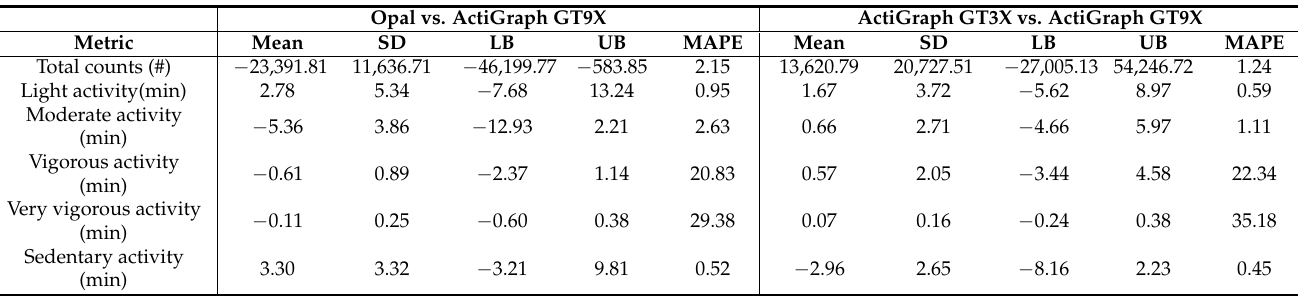
on activity measures (FreedsonVM3).